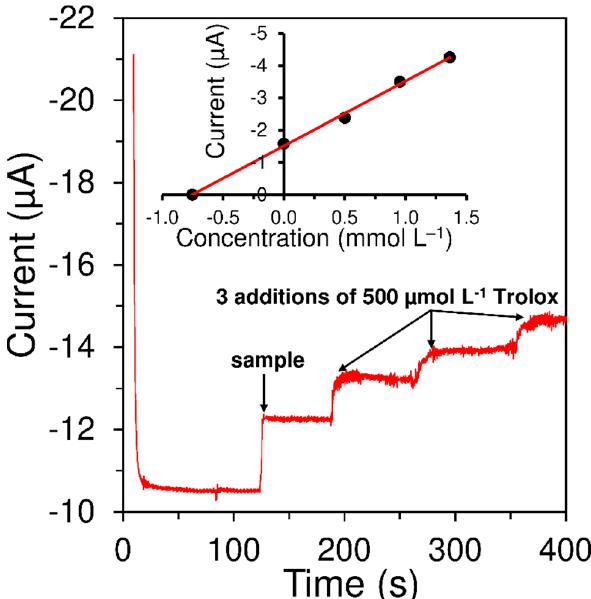
Figure 5. Representative TEAC analysis of raspberries using multiple standard additions method with CPE/MWCNTs/TYR/Nafion ® biosensor at constant working potential -0.25 V and stirring speed of 400 rpm.